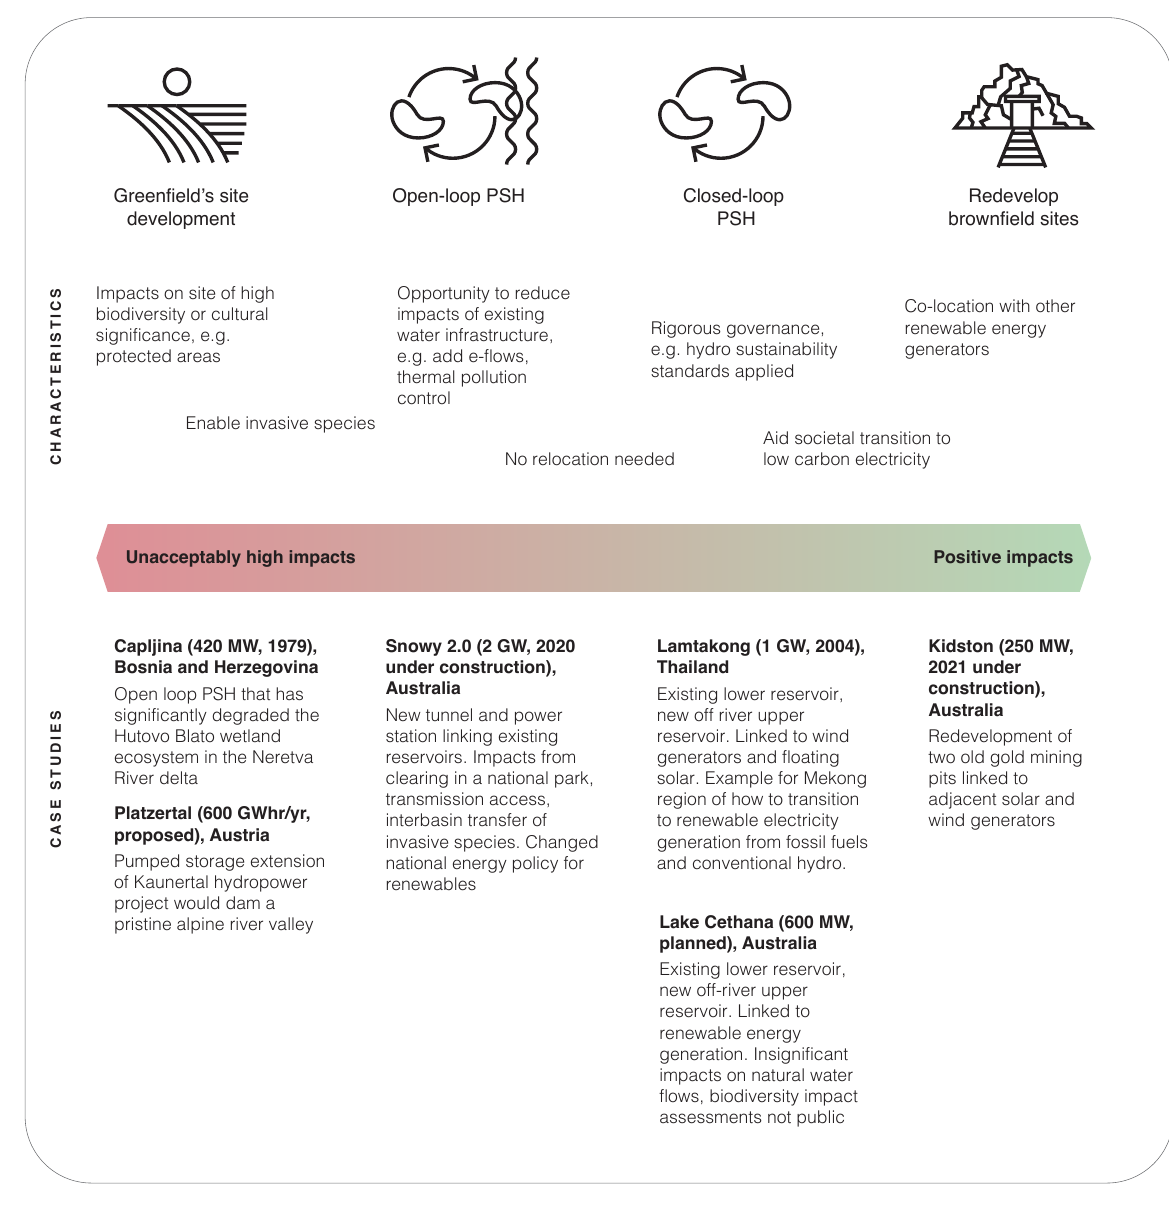
Figure 3. Spectrum of environmental impacts of potential pumped storage hydropower developments (Source: